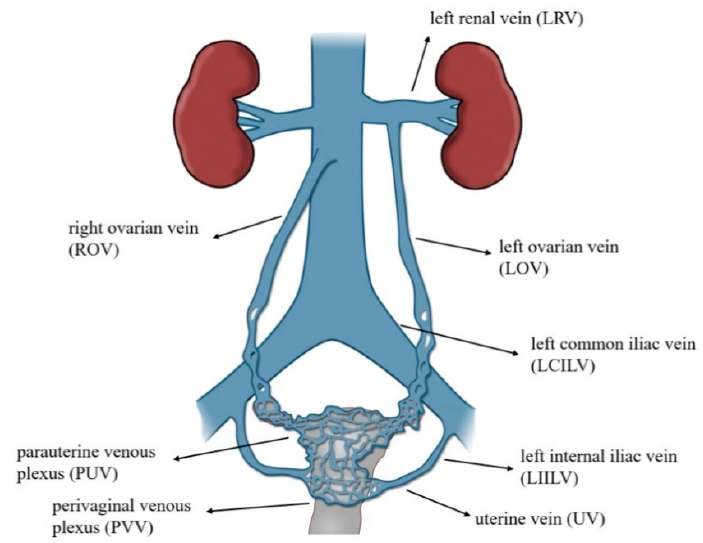
Figure 1. Illustration of abdominal and pelvic venous system in women.